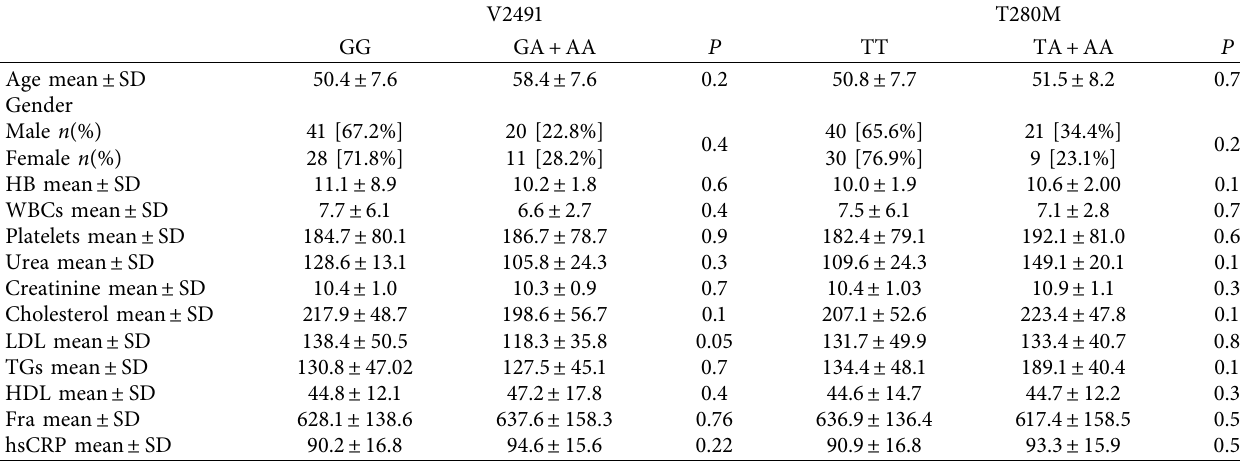
Table 4: Comparison of demographic and laboratory data between patients with different genotypes of